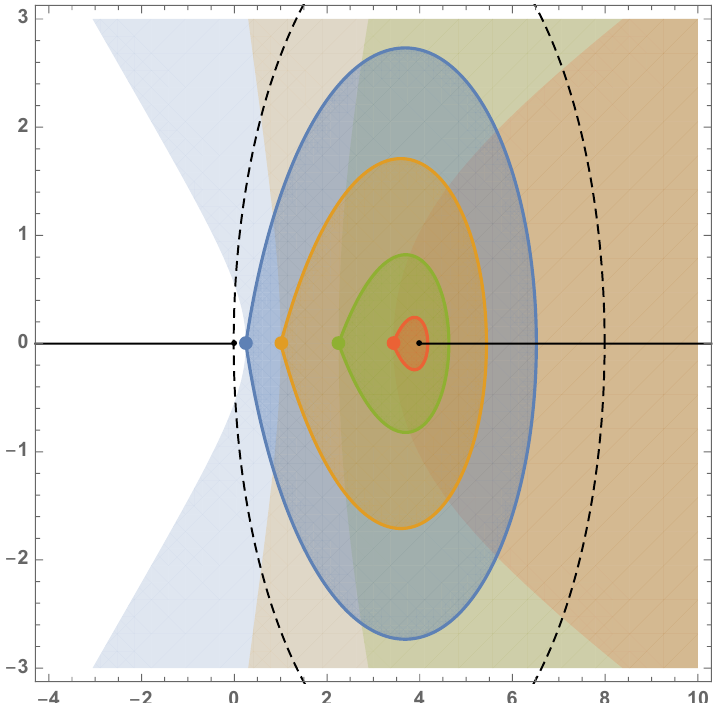
Figure 11. Regions in the complex s plane where the pole at c = ∆ b is picked up (lighter shaded) and the smaller subregion where the flat-space limit diverges (darker shaded). The different colors correspond to m b = 0 . 5 , 1 , 1 . 5 , 1 . 85 and we have set m = 1 . The problematic region for the exchange diagram always lies within the disk given by | s − 4 m 2 | < 4 m 2 . We assumed that the external momenta are chosen such that momentum conservation